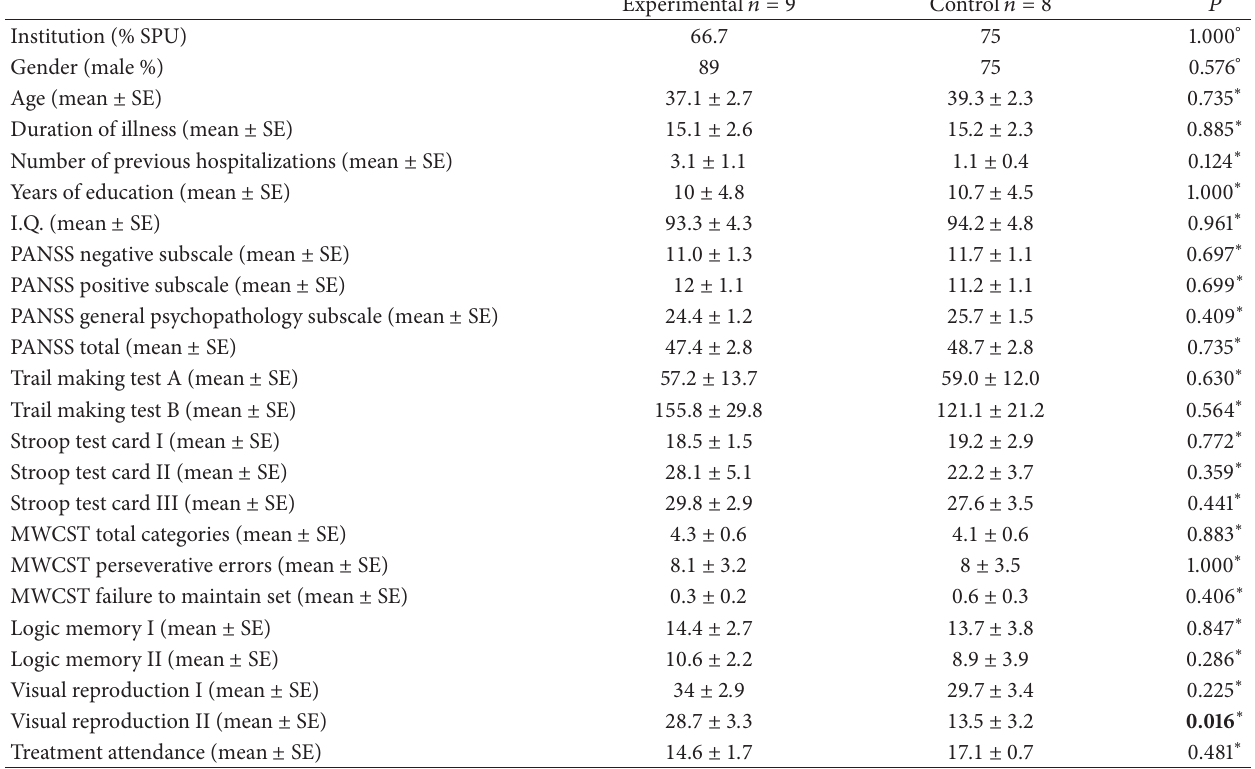
Table 1: Demographic and clinical characteristics at baseline and treatment